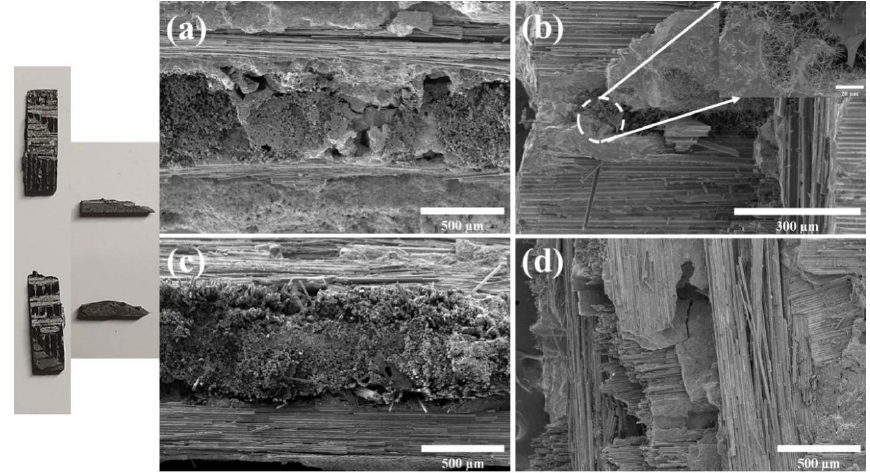
Fig. 15 Photographs and microstructures of fractured surfaces of samples 4C# and 8C#. Table 8 Thermal conductivities and bending strengths of recently reported fiber-reinforced ceramic matrix composites in comparison with the materials prepared in this study